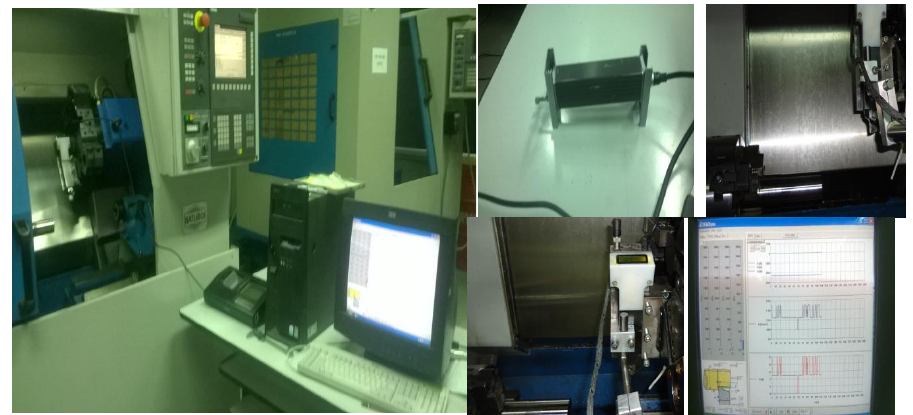
Figure 2. Experimental Set-up. Table 3. Machining Parameters and their Levels.